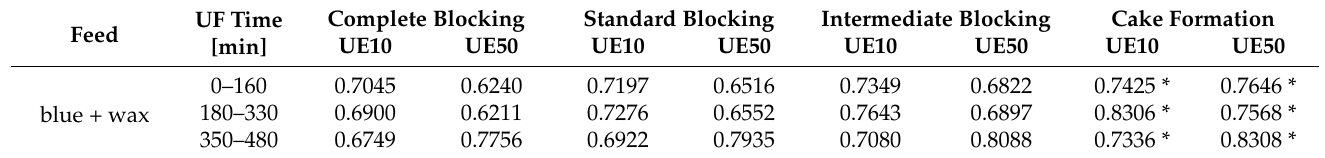
Table A5. Coefficient of determination (R 2 ) Hermia’s model. The wastewater concentration by UF process (Figure 13).